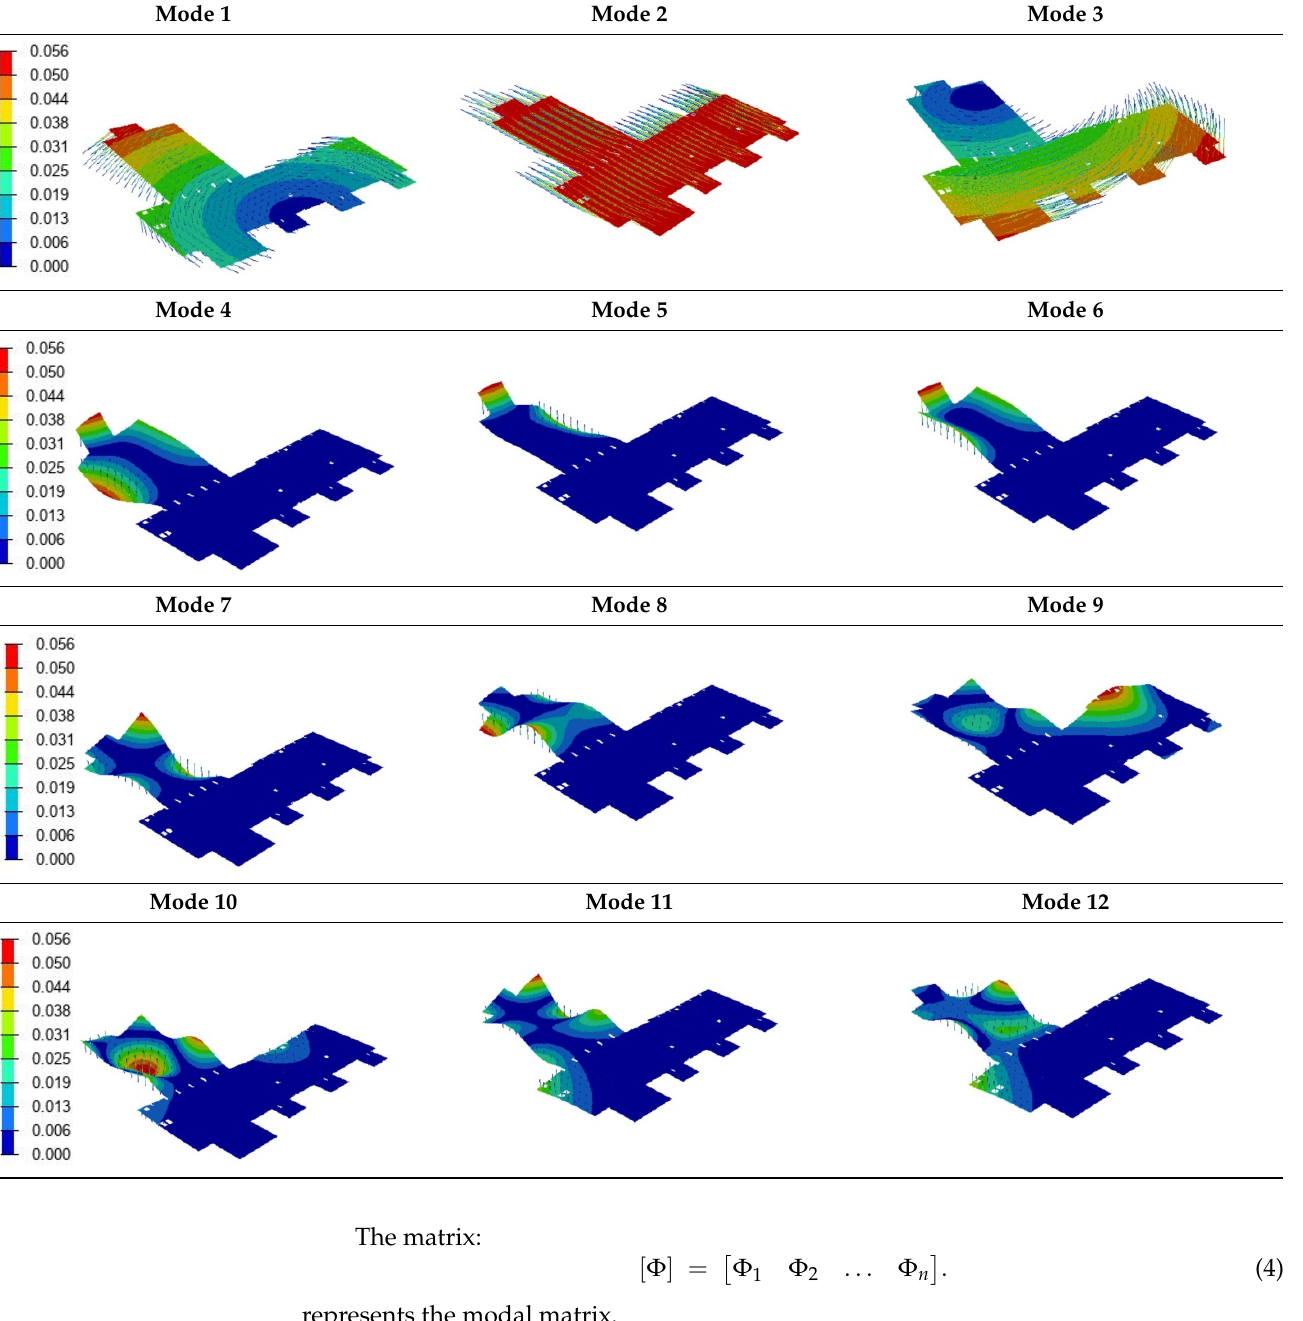
Table 2. The first 12 eigenmodes.